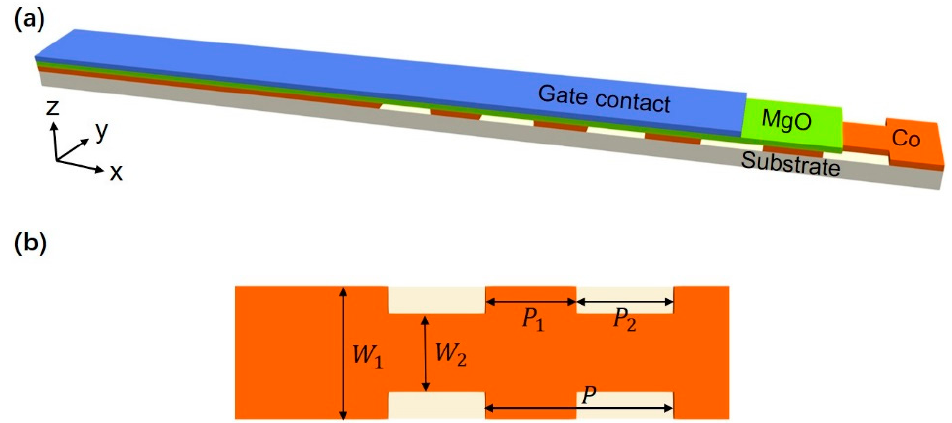
Figure 1. ( a ) Schematic illustration of the width-modulated nanostrip magnonic-crystal waveguides. The film stack is a metal/MgO/Co (1.5 nm)/insulate substrate. The top layer is the gate metal. A voltage was applied on the gate contact to tune the anisotropy. The Co layer is fabricated with periodic width modulations. ( b ) Four parameters characterize the geometry of the Co layer: the width of the nanostrip, W 1 , and a second width at the narrow place, W 2 ; the lengths of the segments with widths W1 and W2 are P 1 and P 2 , respectively. In the simulation, we used W 1 = 30 nm, W 2 = 18 nm, P 1 = 18 nm, and P 2 = 21 nm.